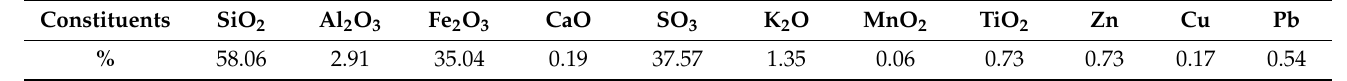
Table 4. Elemental composition by XRF of the gold–silver tailing